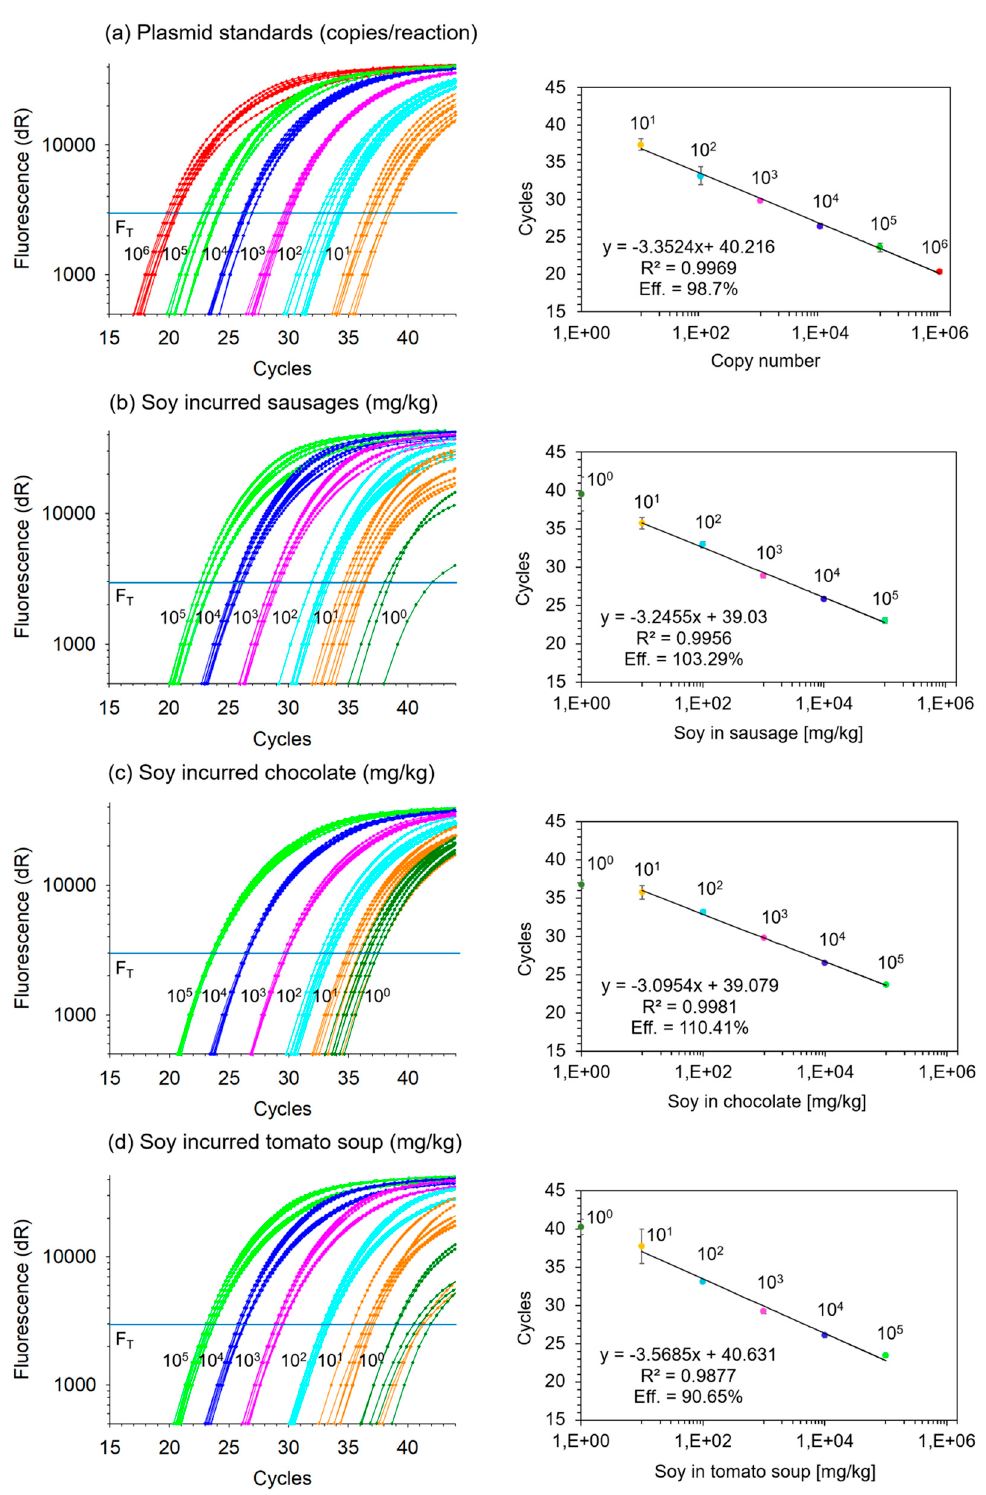
Figure1. Lectin qPCR:Amplificationcurves(leftpanel)andlinearregression(rightpanel)offluorescence threshold (F T ) cycles versus lectin copy numbers or mg / kg soy in matrix ( a ) plasmid DNA standards between 10 1 and 10 6 copies per reaction; ( b ) soybean incurred between 10 0 and 10 5 mg per kg sausage; ( c ) soybean incurred between 10 0 and 10 5 mg per kg chocolate; ( d ) soybean incurred between 10 0 and 10 5 mg per kg tomato soup. Each level of plasmid DNA standard or incurred soybean sample was analyzed in eight replicate reactions each (error bars indicate standard deviation of replicate means; R 2 : coe ffi cient of determination; E ff : e ffi